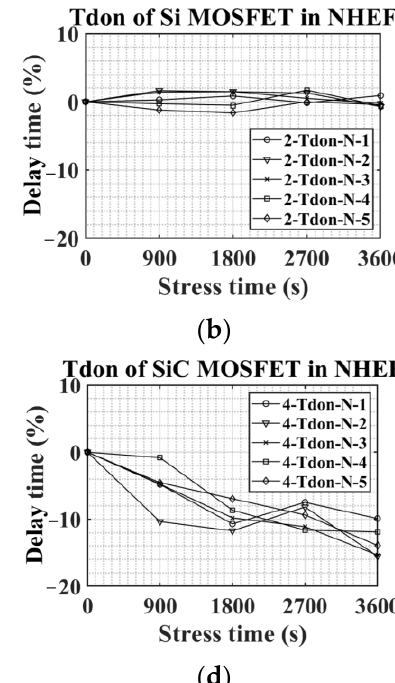
Figure 14. Turn on waveforms in NHEF stress: ( a ) 1-Tdon-P-1, ( b ) 2-Tdon-P-2, ( c ) 3-Tdon-P-1, and